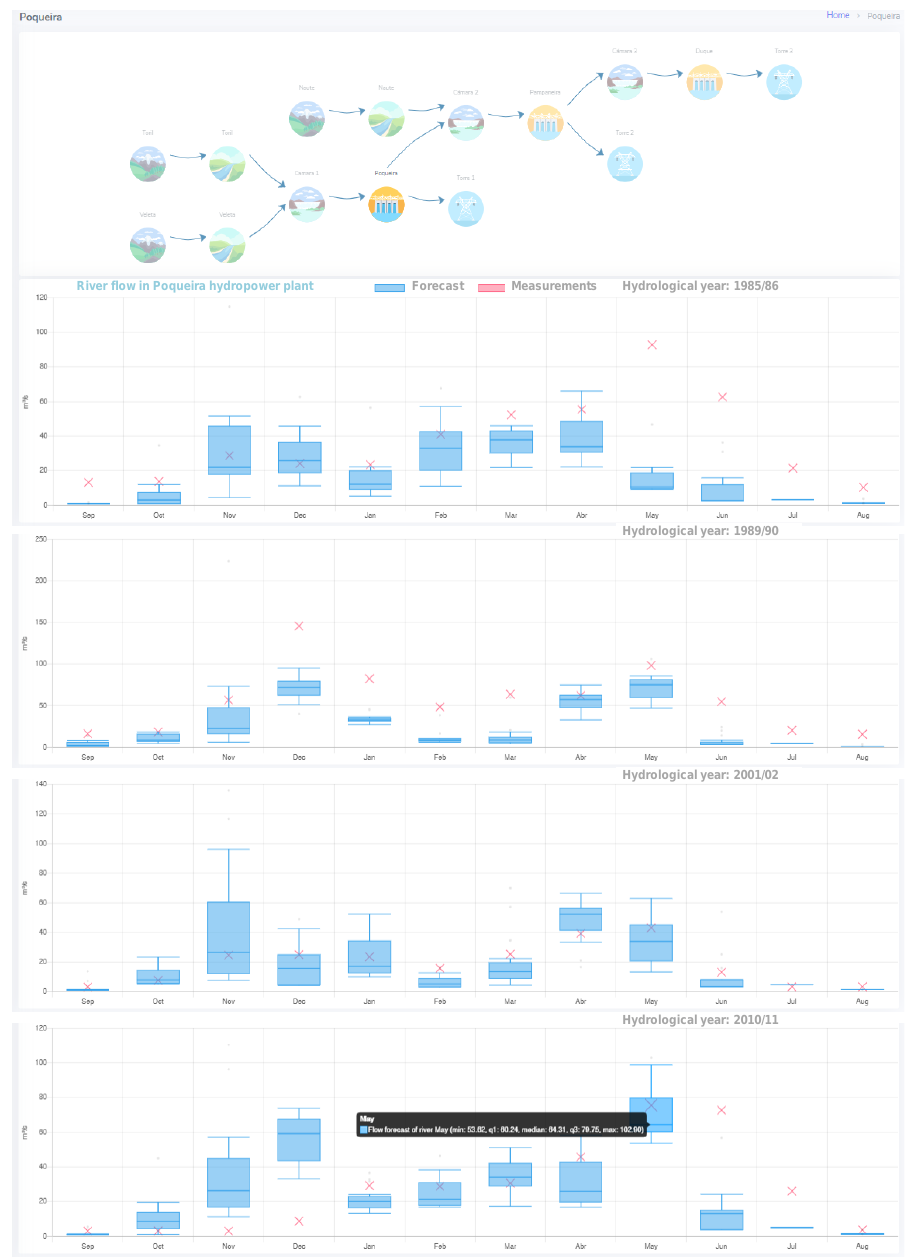
Figure 7. Example of the visualization of the SHYMAT web-user interface. Historical mode outputs: The hydropower plant element is selected in the topology panel and a graph showing the forecast (boxplot) and real (point) data of monthly river flow data for the hydrological years 1985/86, 1989/90, 2001/02, and 2010/11 appears on the screen. In the last graph, an example of the statistical information (minimum, quartile 1, median, quartile 3, and maximum) is displayed.